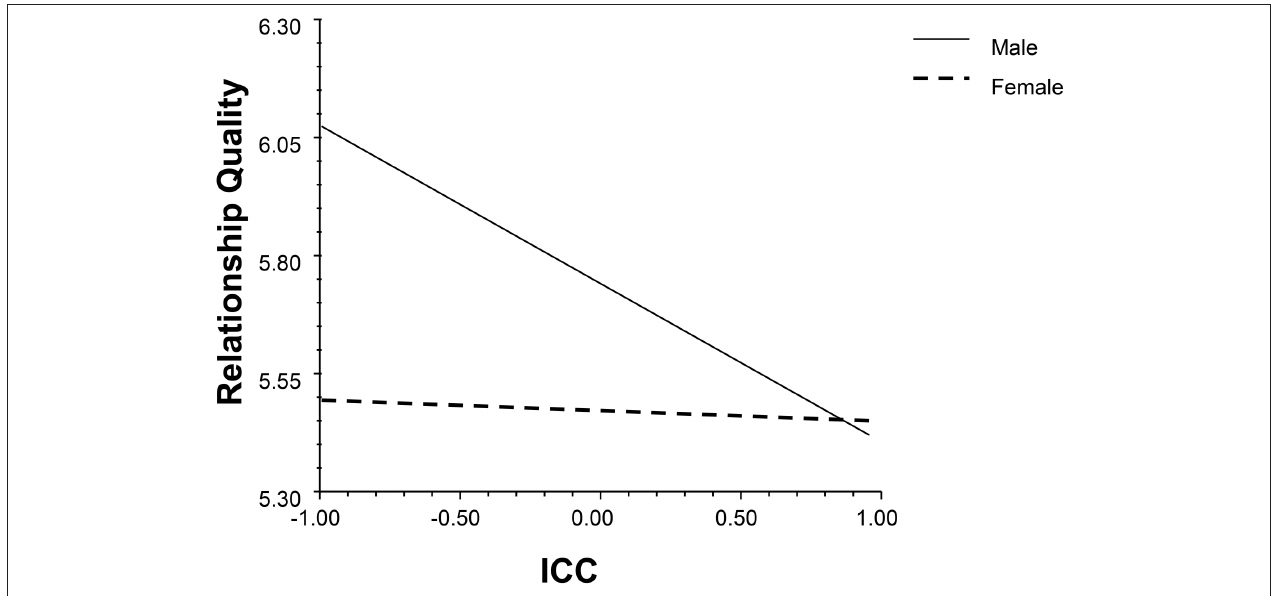
FIGURE 9 | The interaction between ICC and gender